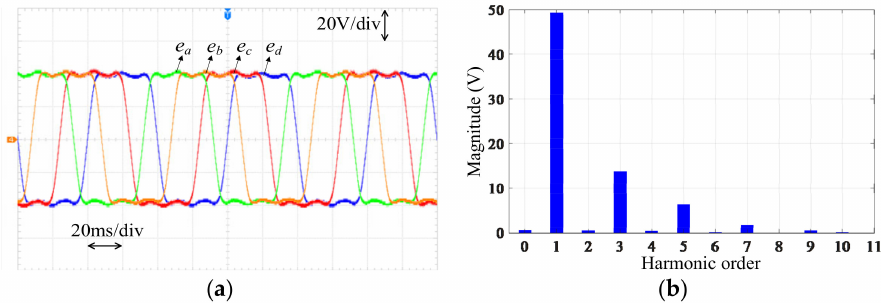
Figure 4. Back-EMFs of the used five-phase PMSG at 50Hz: ( a ) Waveforms, ( b ) Harmonic orders.